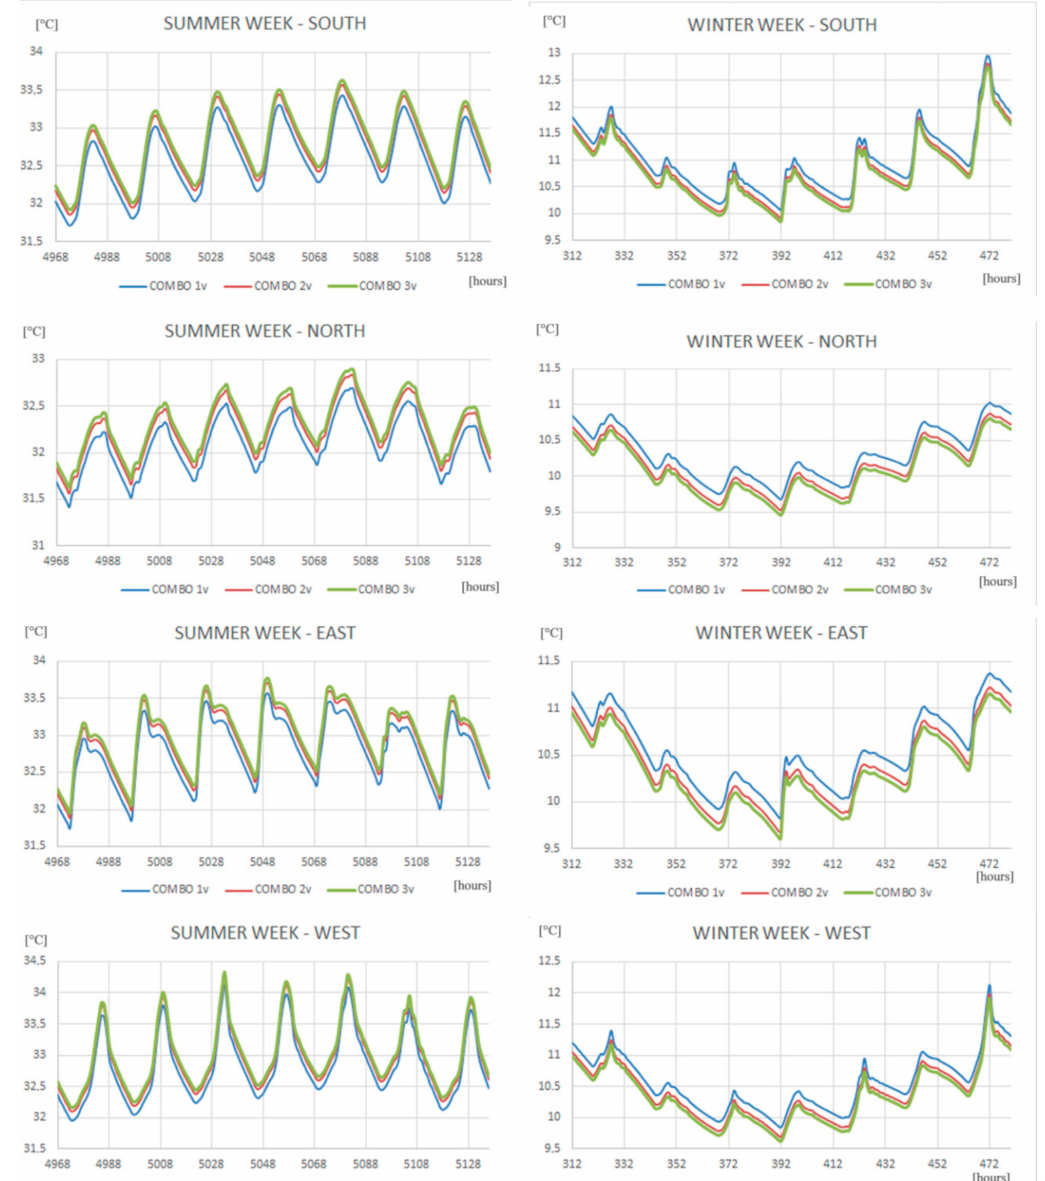
Figure 5. TOP trend for Combo 1v, 2v, and 3v (27 July–2 August; 14 January–20